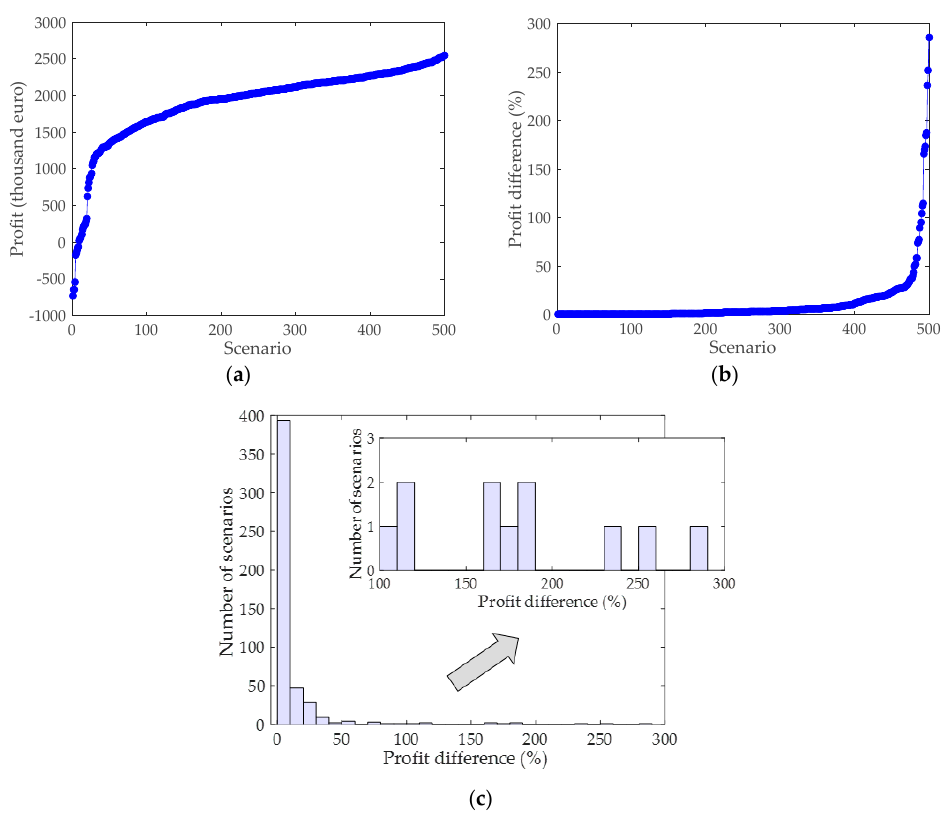
Figure 21. Out ‐ of ‐ sample results. ( a ) Profit per scenario considering storage; ( b ) difference between Figure 21. Out-of-sample results. ( a ) Profit per scenario considering storage; ( b ) di ff erence between the the profits of cases with and without storage, ( c ) histogram of the difference between profits of cases profits of cases with and without storage, ( c ) histogram of the di ff erence between profits of cases with with and without storage. and without